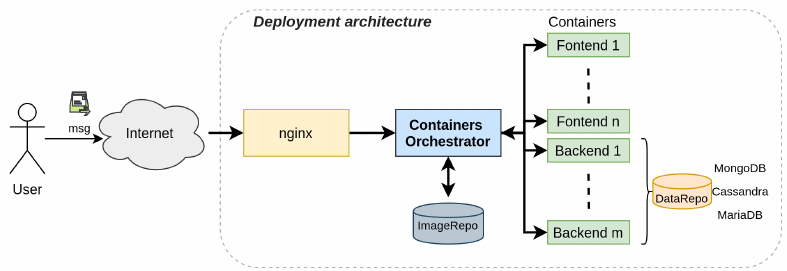
Figure 1. General scheme of the proposed